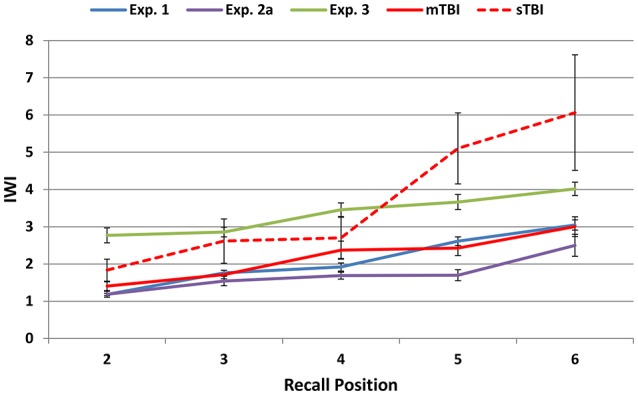
Mean inter-word intervals (IWIs) for words 2 through 6 in the different experiments. The data were averaged over trials of different types and output lengths. See Figure 2 for abbreviations.